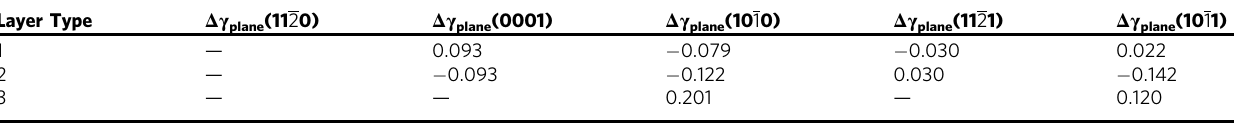
Table 1 Relative difference in surface energy values between different layers calculated for DNA-gold nanoparticle superlattices Layer Type